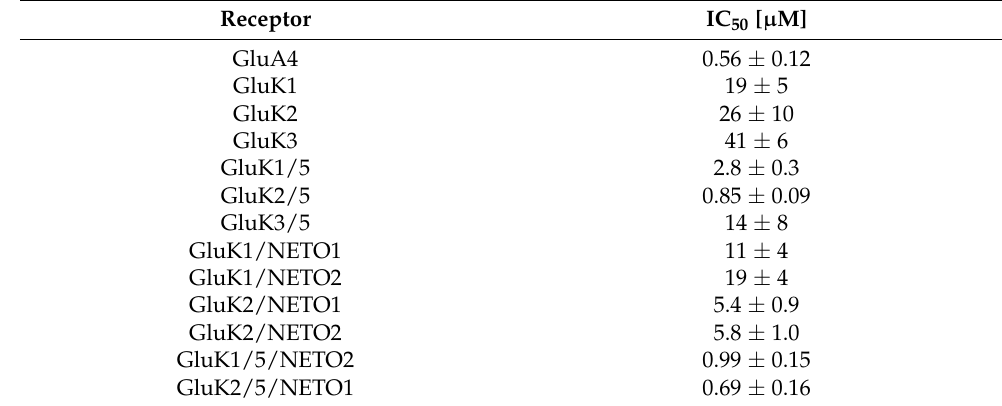
Table 9. IC 50 values for perampanel inhibition in voltage-clamp recordings from recombinant homomeric and heteromeric KARs expressed in HEK293-T/17 cells (adapted from ref. [166]).